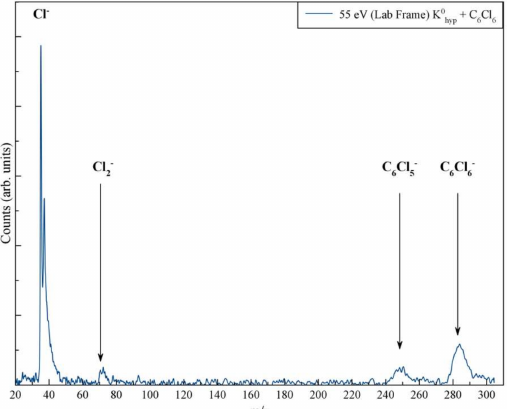
Figure 1. Time-of-flight negative ion mass spectrum in K–C 6 Cl 6 collisions at 55 eV lab frame energy (43.5 eV in the center-of-mass frame). The spectrum shows the intensity of m/z